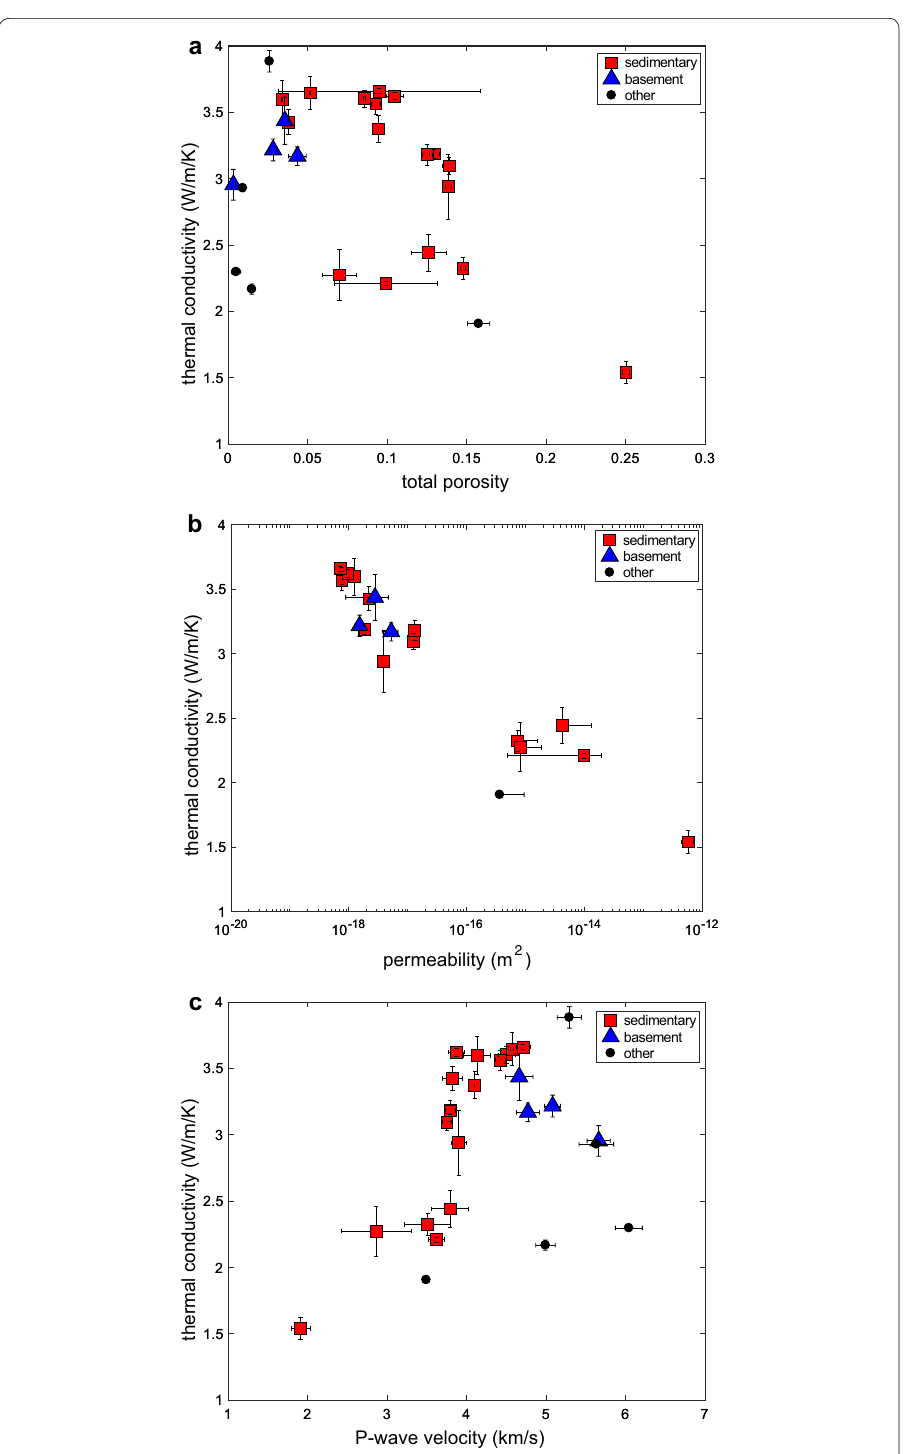
Fig. 7 Thermal conductivity of all rocks investigated as a function of a total porosity, b permeability, and c P-wave velocity. All rocks are categorised as either sedimentary (red squares), crystalline basement (blue triangles), or other lithologies (black circles); see Table 2. Thermal conductivity, porosity, permeability and P-wave velocities shown are the mean values for each rock type; error bars indicate the standard deviation of each mean